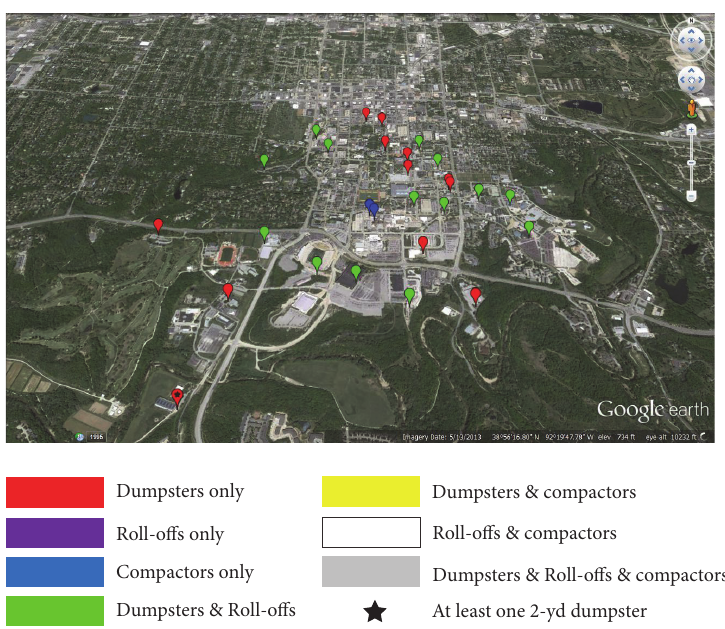
Figure 7: Distribution of receptacles around MU campus, nonrobust ( 𝜂 = 0 ) solution, maximum transport distance of 0.25 miles.